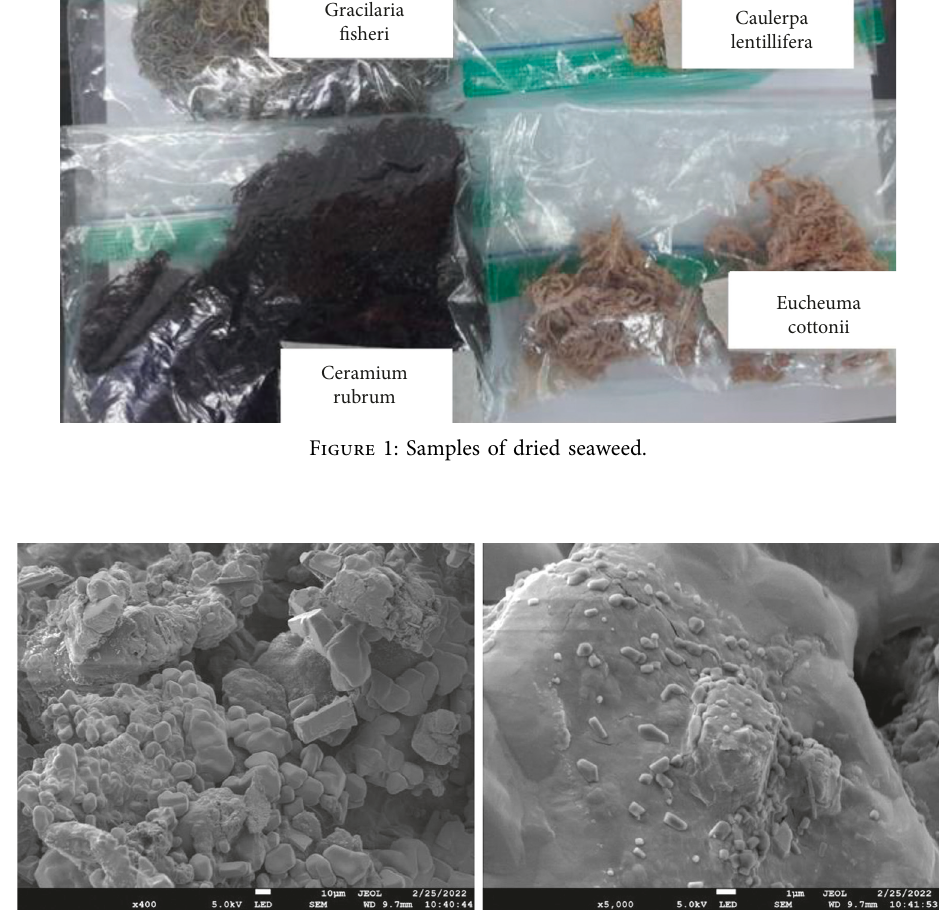
Figure 2: Scanning electron microscopy (SEM) images of Gracilaria fisheri at 10 μ m and 1 μ